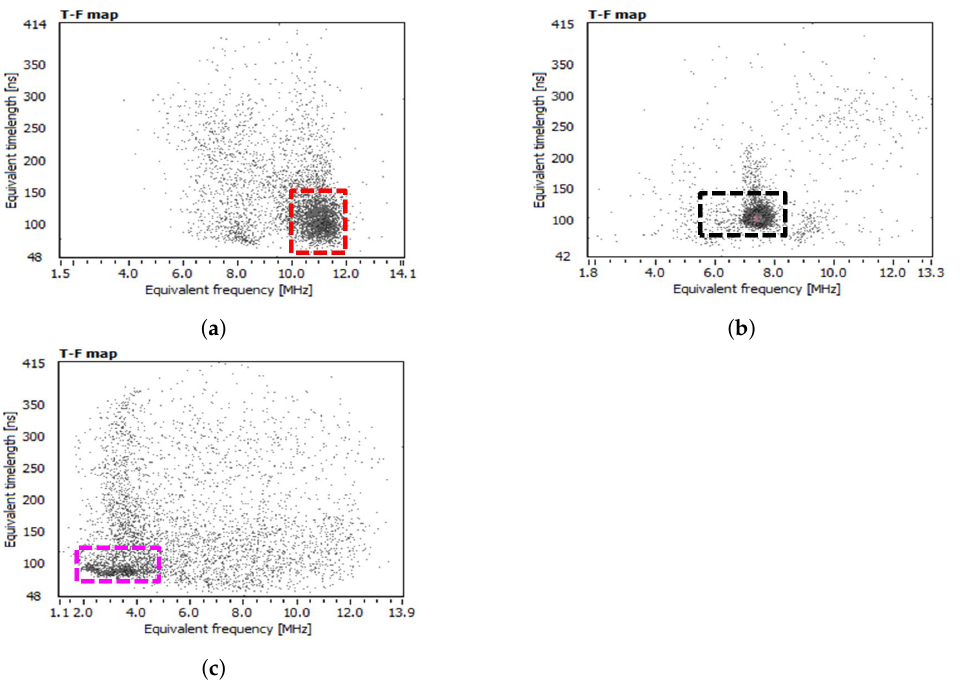
Figure 6. TF map clusters obtained during positive DC IPT. ( a ) Mobile discharge pulses form cluster having greatest W 2 coordinates. ( b ) Localized discharge pulses form cluster with mid-range W 2 coordinates. ( c ) High temperature discharge pulses form a cluster with lowest W 2